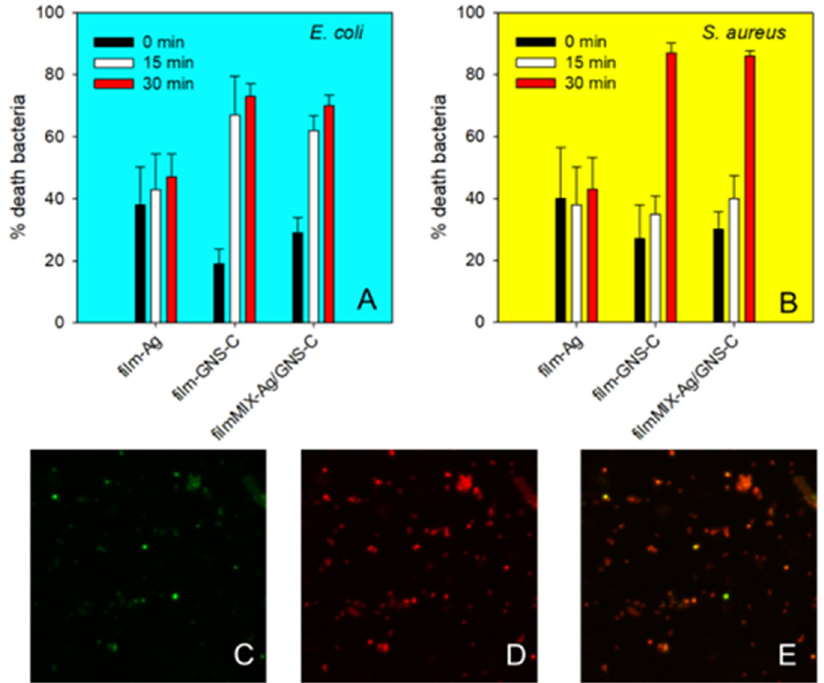
Figure 8. ( A ) Percent fraction of death of E. coli bacteria inoculated in the films, with no irradiation (black bars) and laser irradiated at 808 nm for 15 min (white bars) and 30 min (red bars) and ( B ) same, for S. aureus . ( C ) Green channel (living cells) in stained filmMIX-Ag/GNS-C inoculated with E. coli and irradiated for 30 min; ( D ) same, red channel (death cells); and ( E ) same, both channels.